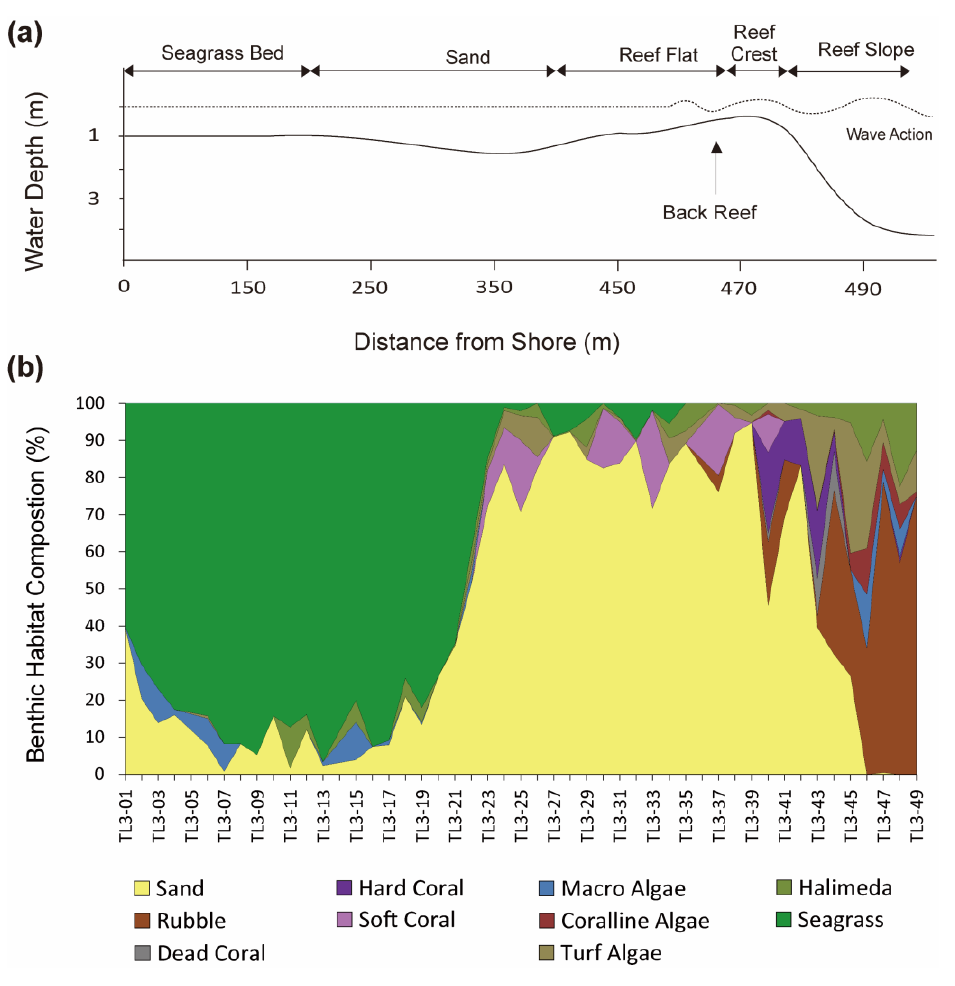
Figure 9. Benthic habitat evaluation results for the third transect line (TL-3). ( a ) Depth profile and topographical zonation from the shoreline to the reef edge. ( b ) Benthic habitat composition of the 49 sampling points (i.e., photo-quadrats) along TL-3.